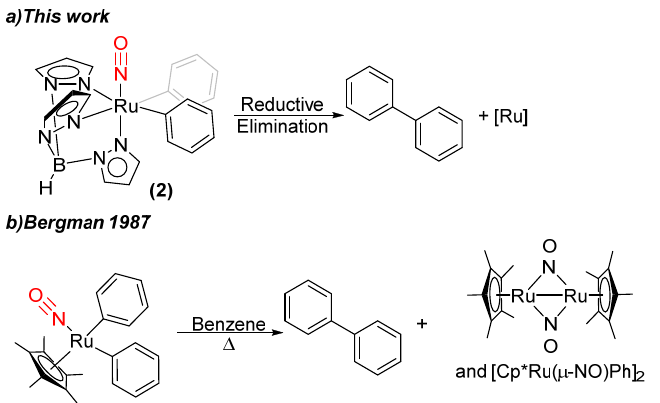
Scheme 3. ( a ) Net reductive elimination of biphenyl from TpRu(NO)Ph 2 ( 2 ) and ( b ) previously reported biphenyl formation from Cp*Ru(NO)Ph 2 [51].